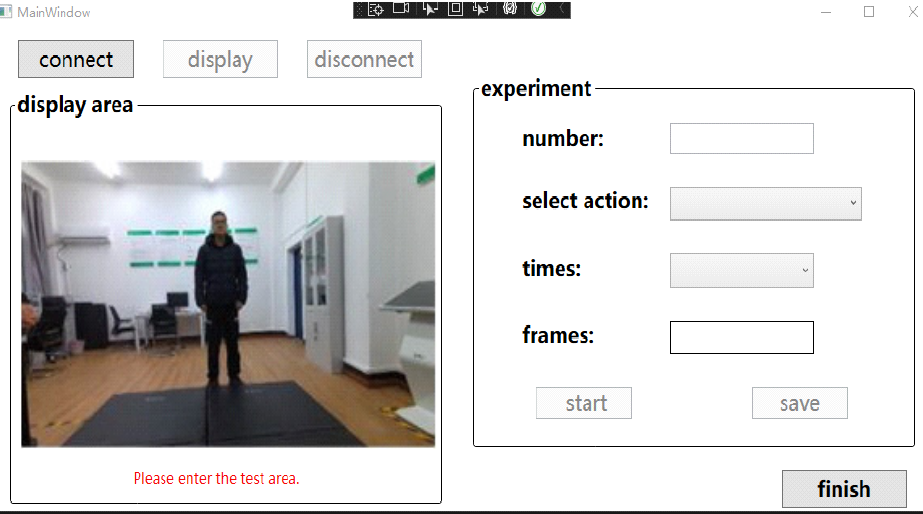
Figure 8. Experimental data collection interface.